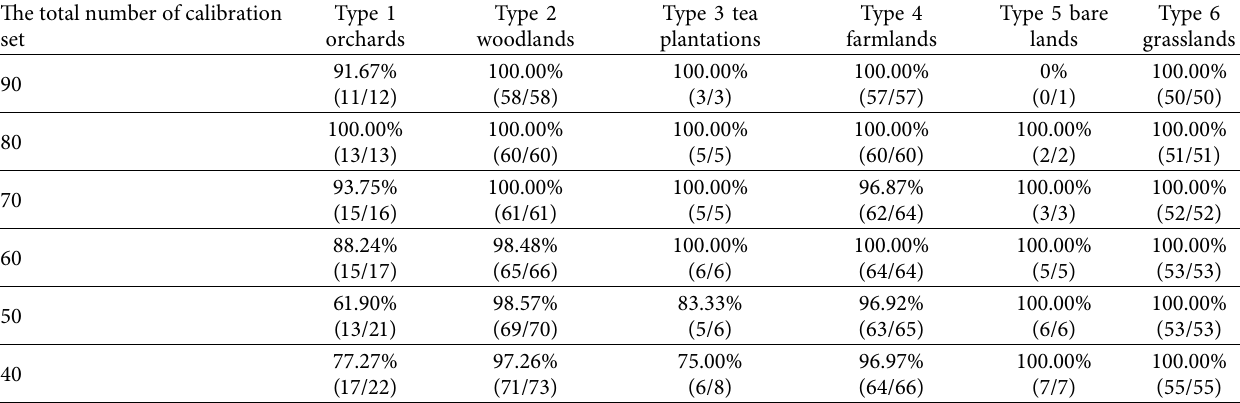
Table 5: The classification results of six types of soil in the test set by convolutional neural network. The total number of calibration